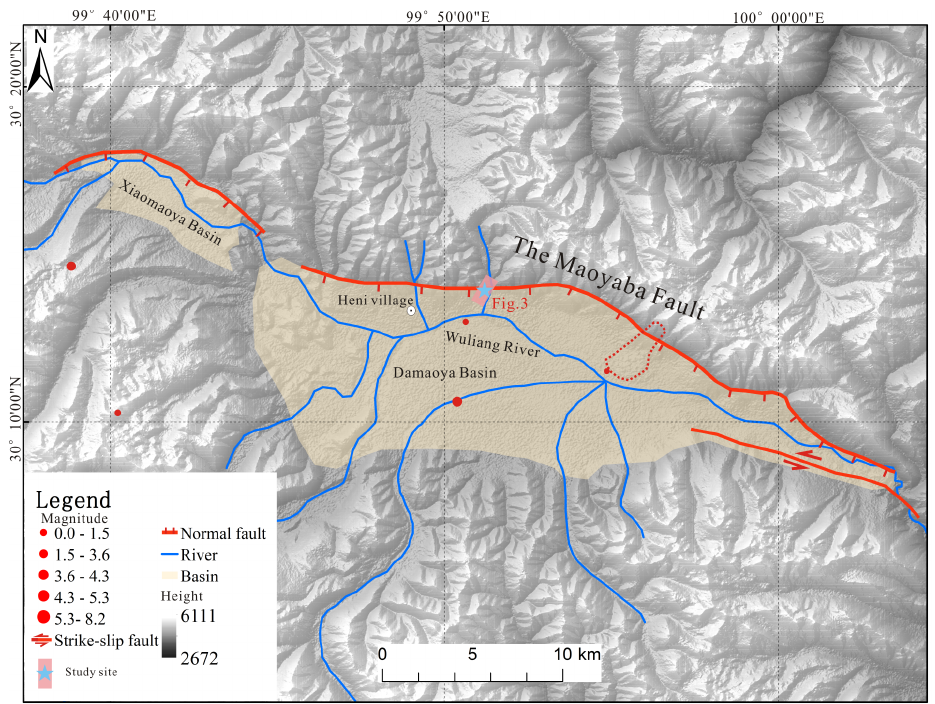
Figure 2. Geometric distribution of the Maoyaba fault. The Maoyaba fault is the main boundary fault almost along the north flank of the Maoyaba basin (red lines). The red dots show the historical earthquakes. The rectangular box represents the survey site in Figure 3 and the red polygon indicates the location of the Luanshibao landslide.